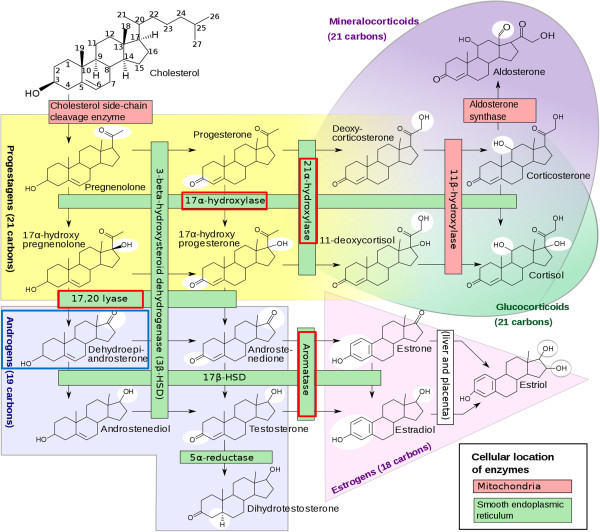
Steroid synthesis. Enzymes indicated with a red box have been found in our analysis. CYP17A1 encodes for an enzyme which has both a 17α-hydroxylase and a 17,20 lyase function. CYP21A2 encodes for a steroid 21-hydroxylase and CYP19A1 encodes for an aromatase. Figure derived from the image Steroidogenesis.png in Wikipedia, by David Richfield and Mikael Häggström, licensed under Creative Commons CC BY-SA 3.0 and GFDL.